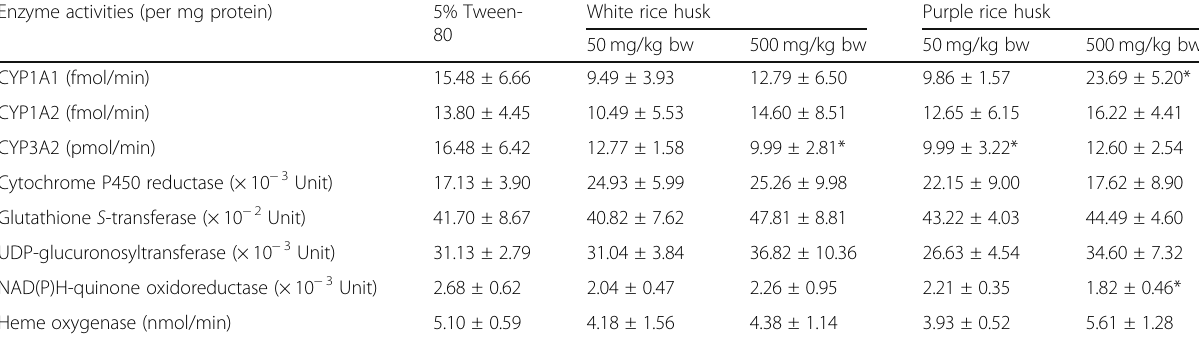
Table 3 Effect of rice husk extracts on xenobiotic metabolizing enzyme activities in the liver of rats Enzyme activities (per mg